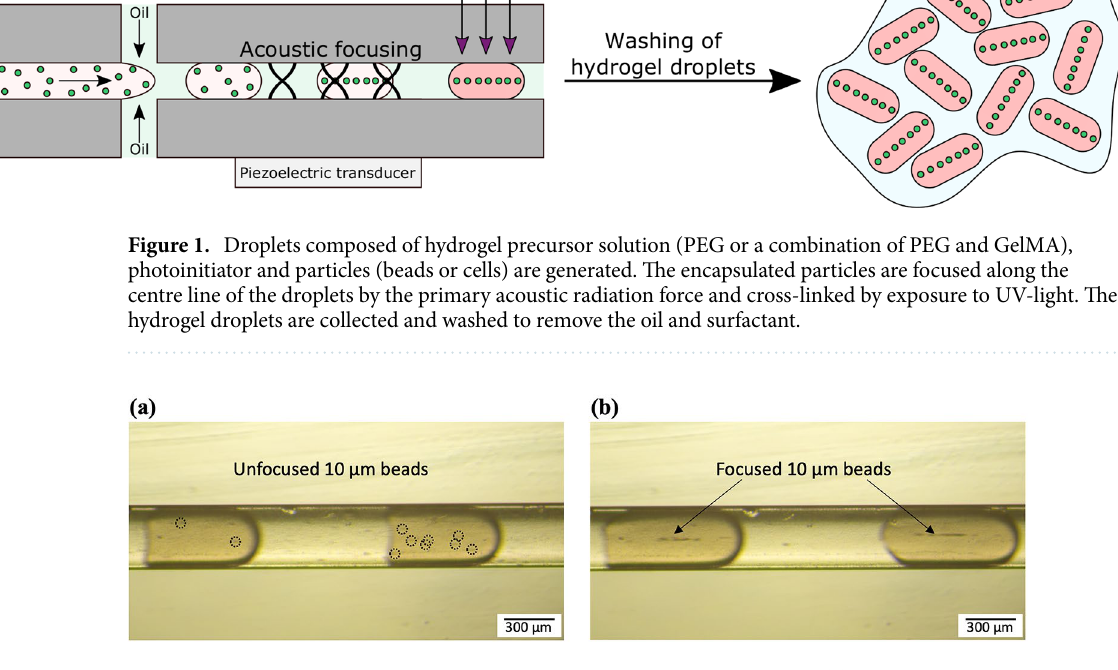
Figure 2. PEG droplets in the acoustic focusing channel before cross-linking. (a) Without the acoustics applied the 10 µm beads are randomly positioned in the droplets. The dashed circles indicate the beads. (b) With the acoustics applied the 10 µm beads are focused along the centre line of the droplets. The flow direction is towards the right in the